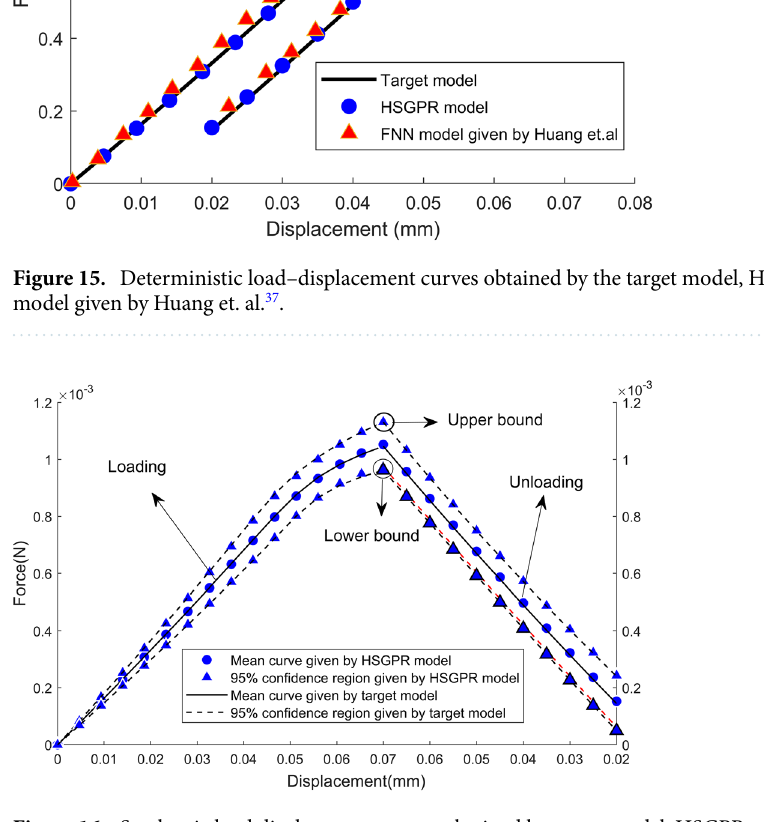
Figure 16. Stochastic load displacement curves obtained by target model, HSGPR